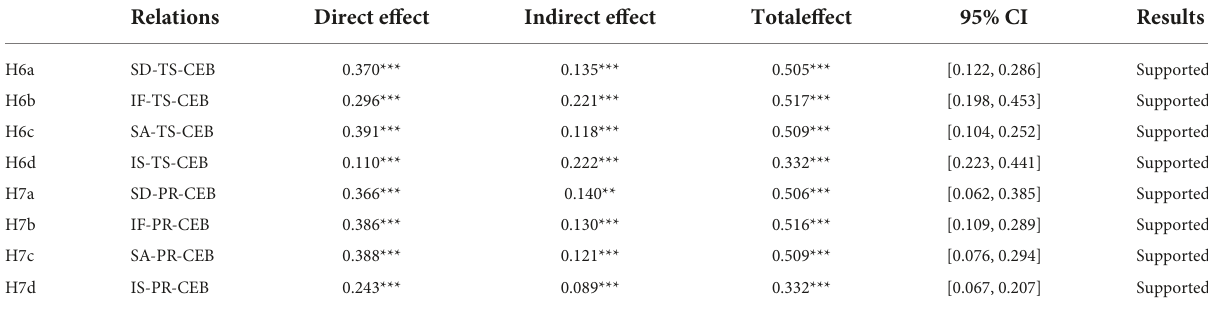
TABLE 5 Test for mediating